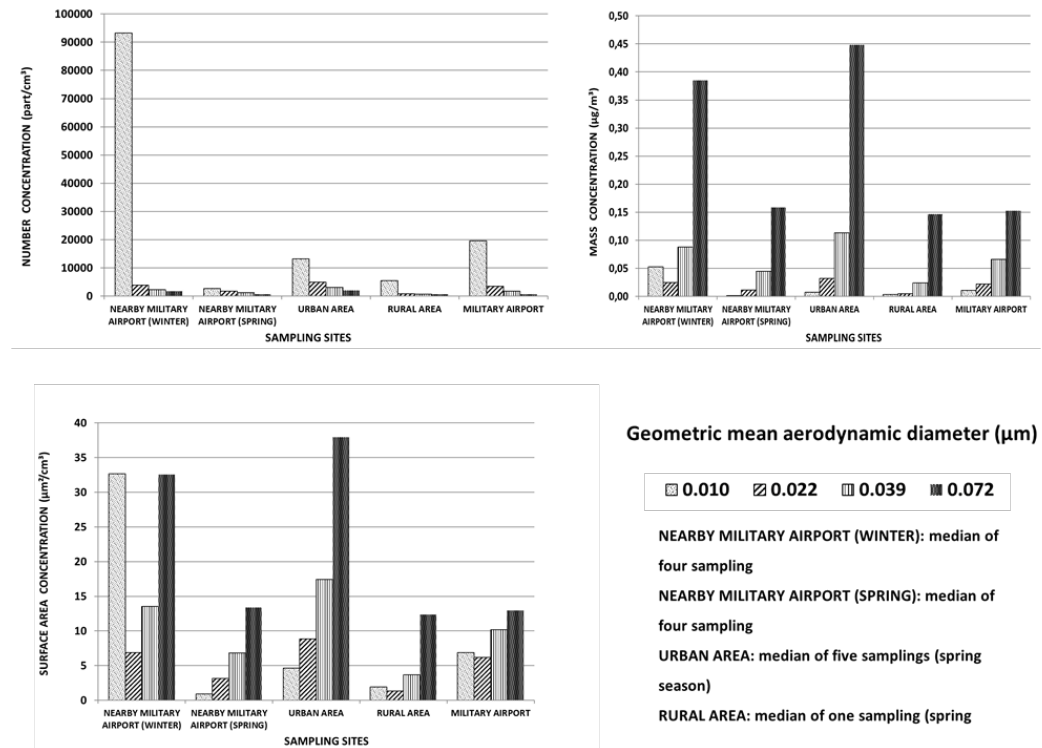
Figure 6. UFP number, mass, and surface area distribution by particle size fraction and sampling location.